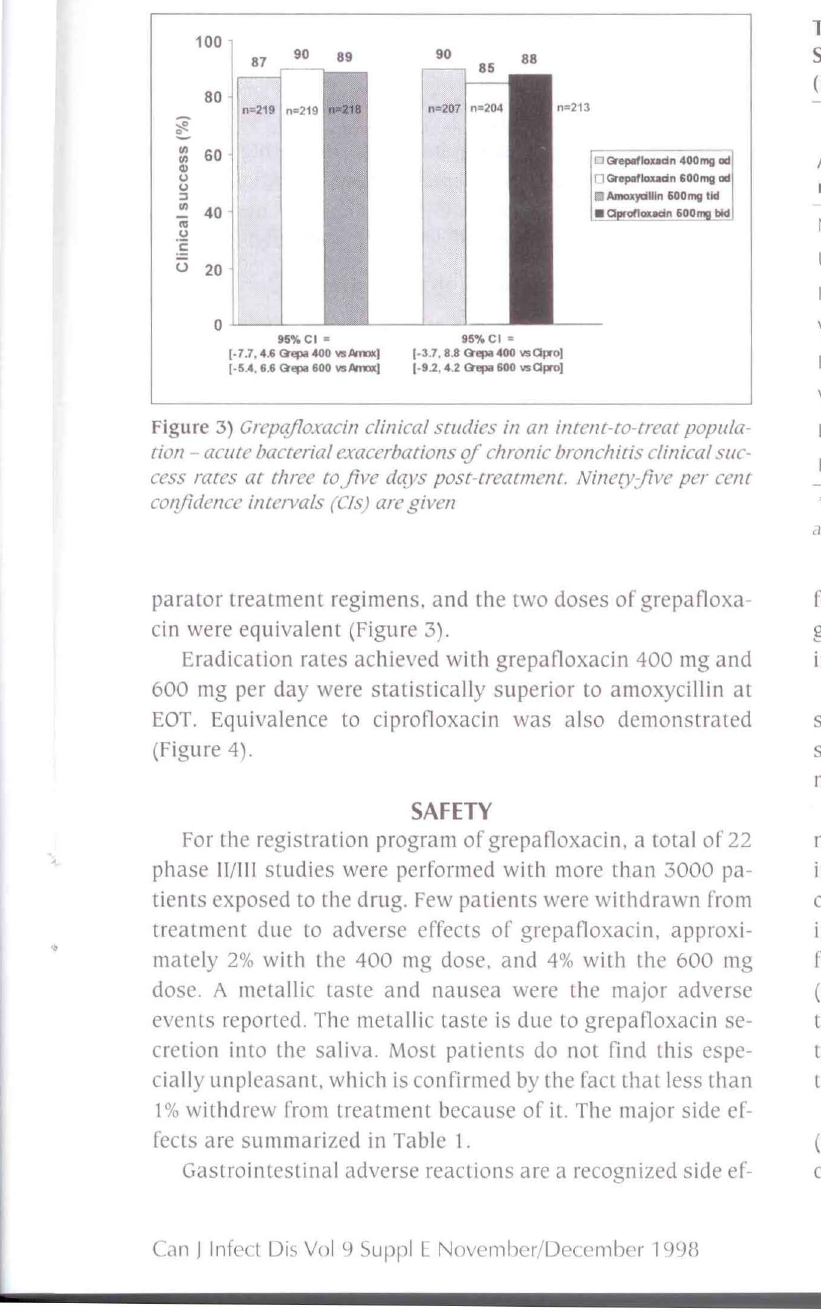
Figure 4) Grcpefloxacin clinical studies in a microbiological intcfll to rrear population (all purhogens) microbiological success rates at rhree to.five dqys posr-treatmcnr. Ninetyfii'C percc11r co,!fidmce inter Fats (C!s) arc gii'l'II